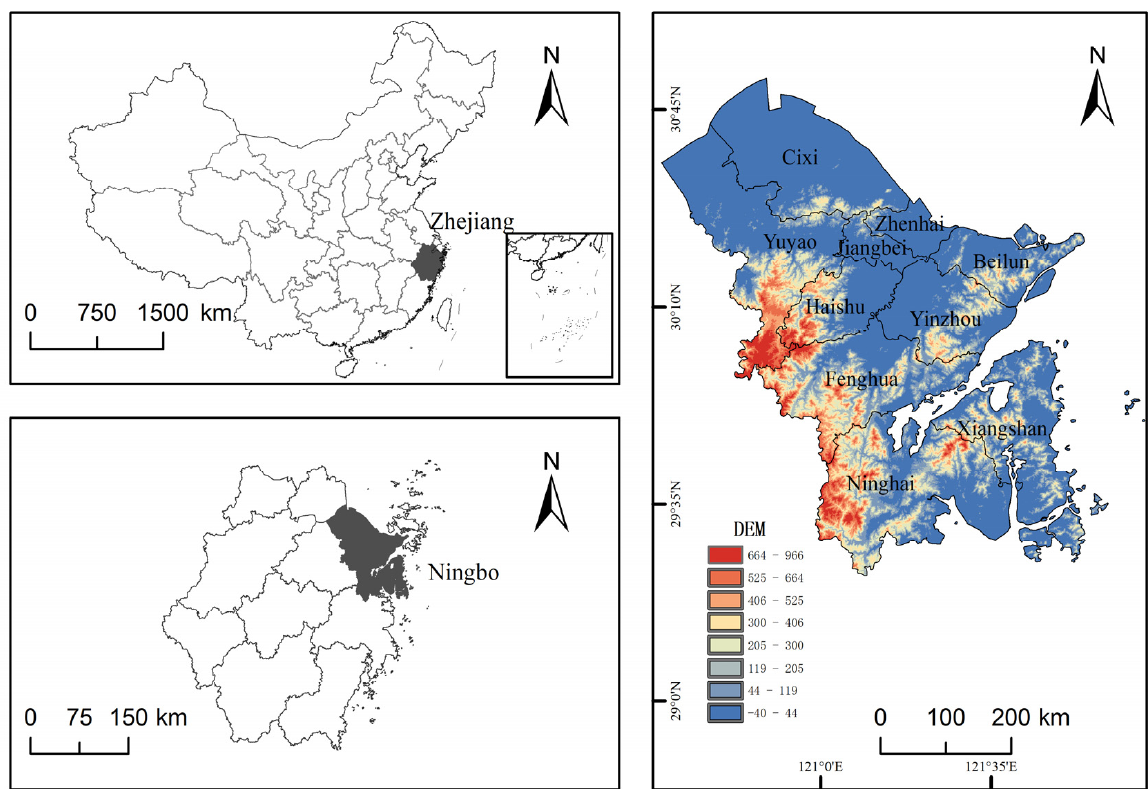
Figure 3. Geographical locations of Zhejiang Province in China ( upper left ), Ningbo in Zhejiang ( lower left ), and digital elevation model (DEM) in Ningbo ( right ).